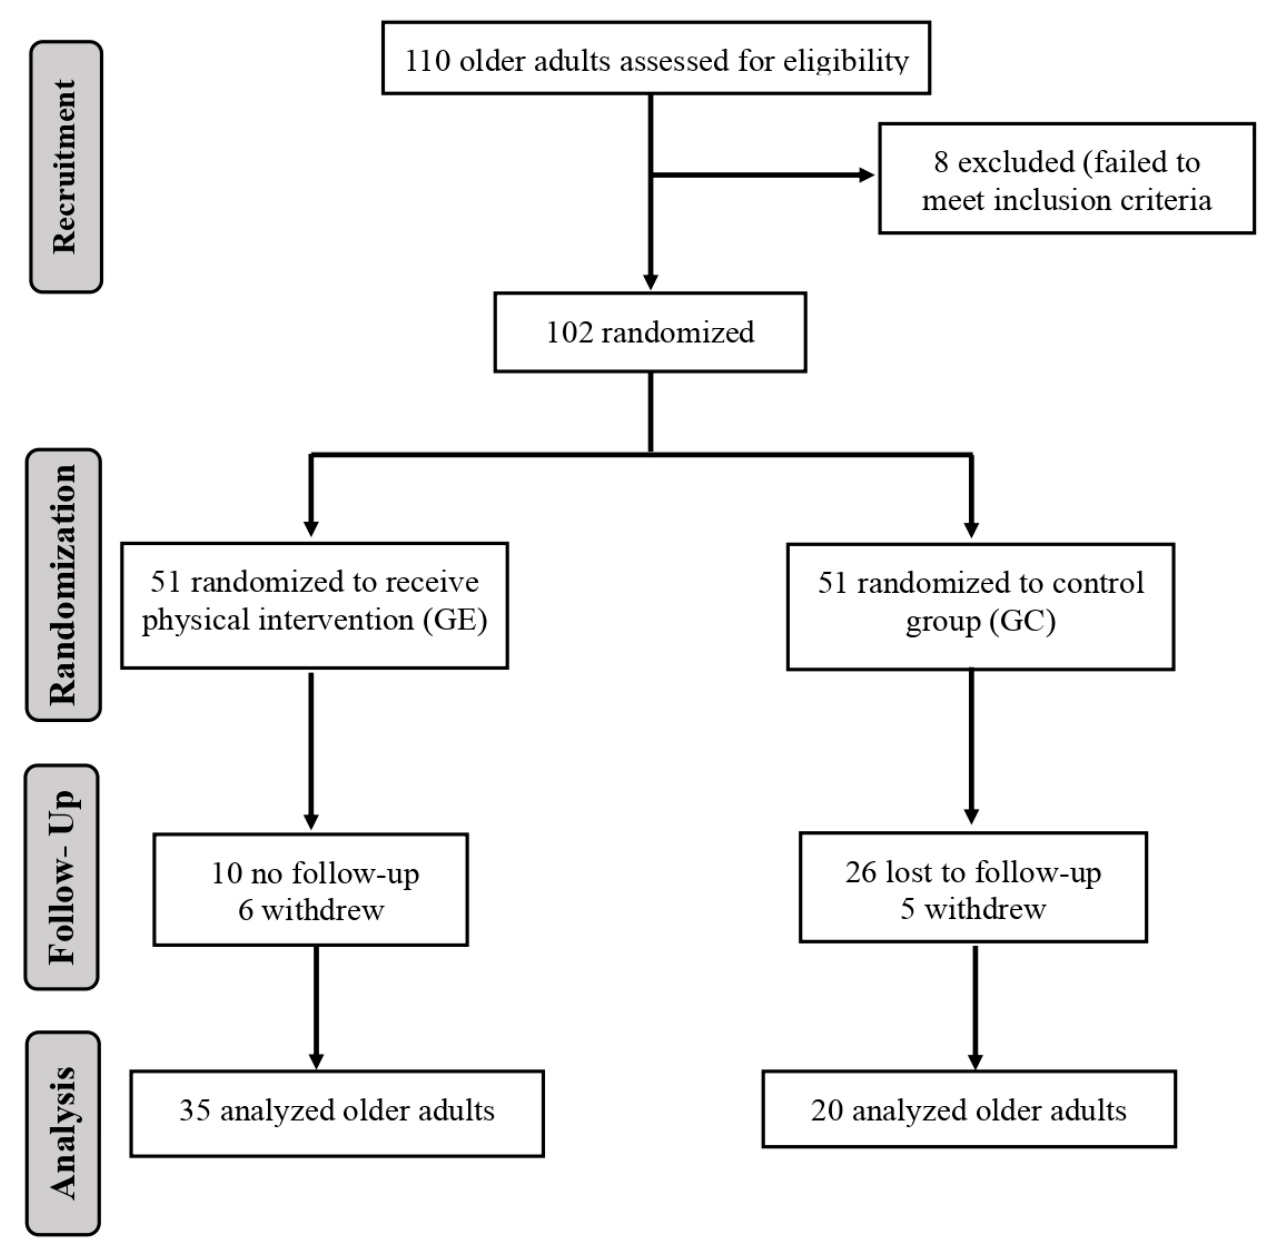
Figure 1. Subjects Flow diagram from initial contact through study completion.